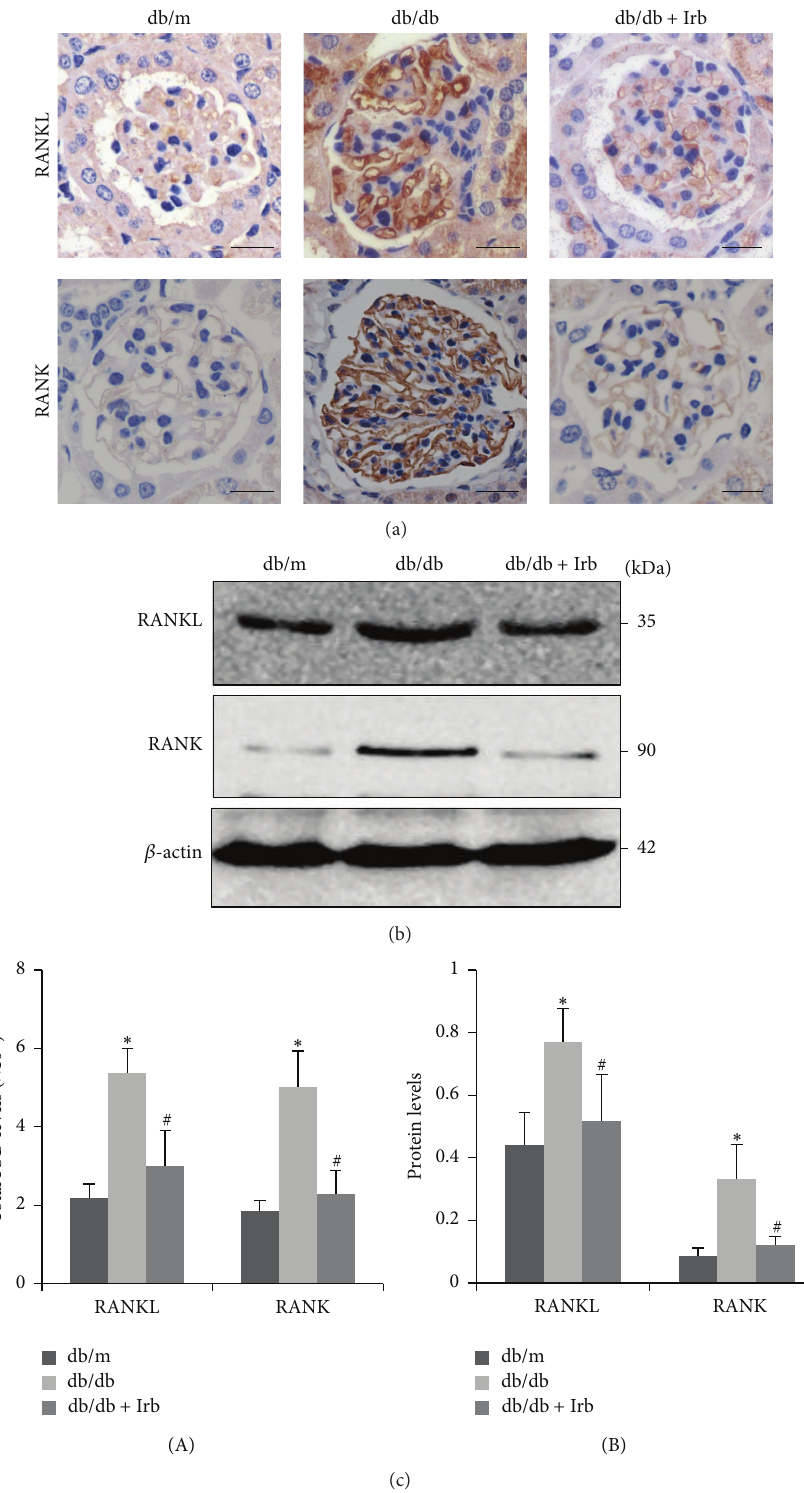
Figure 5: RANKL and RANK were overexpressed in db/db mice and downregulated by Irb. (a) Representative fields of RANKL and RANK, as labeled by immunohistochemical staining (scale bars: 50 𝜇 m). (b) Representative immunoblots of RANKL and RANK expression in the kidney. (c) Quantification of the immunohistochemical staining (A). Quantification of the immunoblot (B): the ratio between RANKL and 𝛽 -actin and the ratio between RANK and 𝛽 -actin are presented. The bars in panel (c) show the mean expression in arbitrary units (error bars, S.D.). ∗ 𝑃 < 0.05 compared with db/m; # 𝑃 < 0.05 compared with db/db, 𝑡